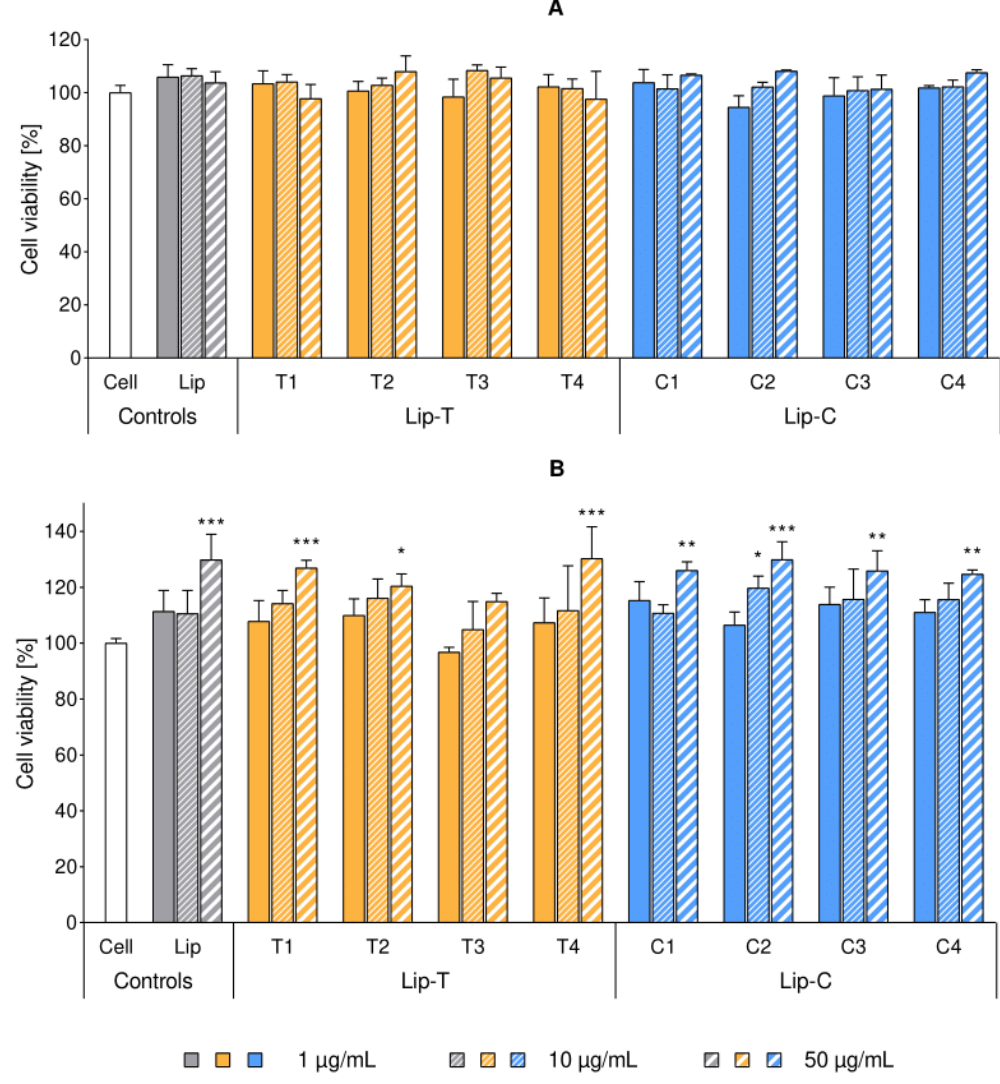
Figure 4. Cytotoxicity of liposomal suspensions tested on RAW 264.7 macrophages (panel A ) and HaCaT keratinocytes (panel B ). Cell proliferation was expressed in percentage, referencing the untreated control (mean ± SD, n = 3). Each cluster refers to the same liposome formulation, applied in three di ff erent concentrations indicated in the legend. Concentration values correspond to the concentration of lipids per well (1, 10 and 50 µ g / mL, complete RPMI-1640). Stars of significance indicate the increased proliferation over cell control (white bar): * p < 0.05; ** p < 0.01; *** p < 0.001. All dye-containing liposomes a ff ected the cell proliferation in a similar manner as empty liposomes. Abbreviations: Lip refers to liposomes; T and C refer to the lipid dye and the surface lipid dye, respectively; Lip-T and Lip-C denote the dye-containing formulation; SD is standard